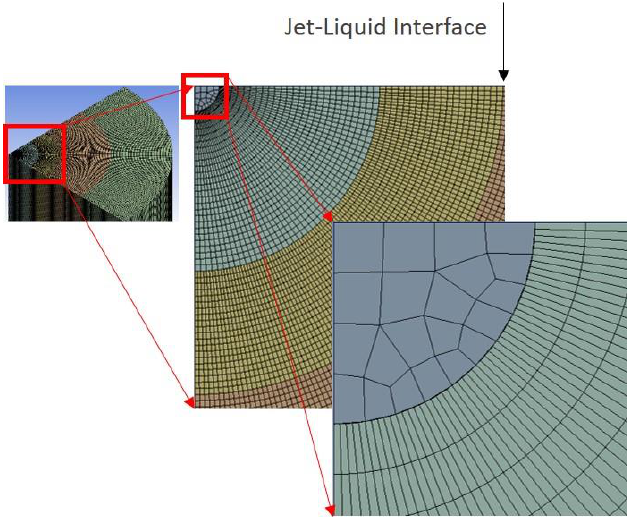
Figure 12. Computational domain and mesh of three-dimensional BLS simulation.